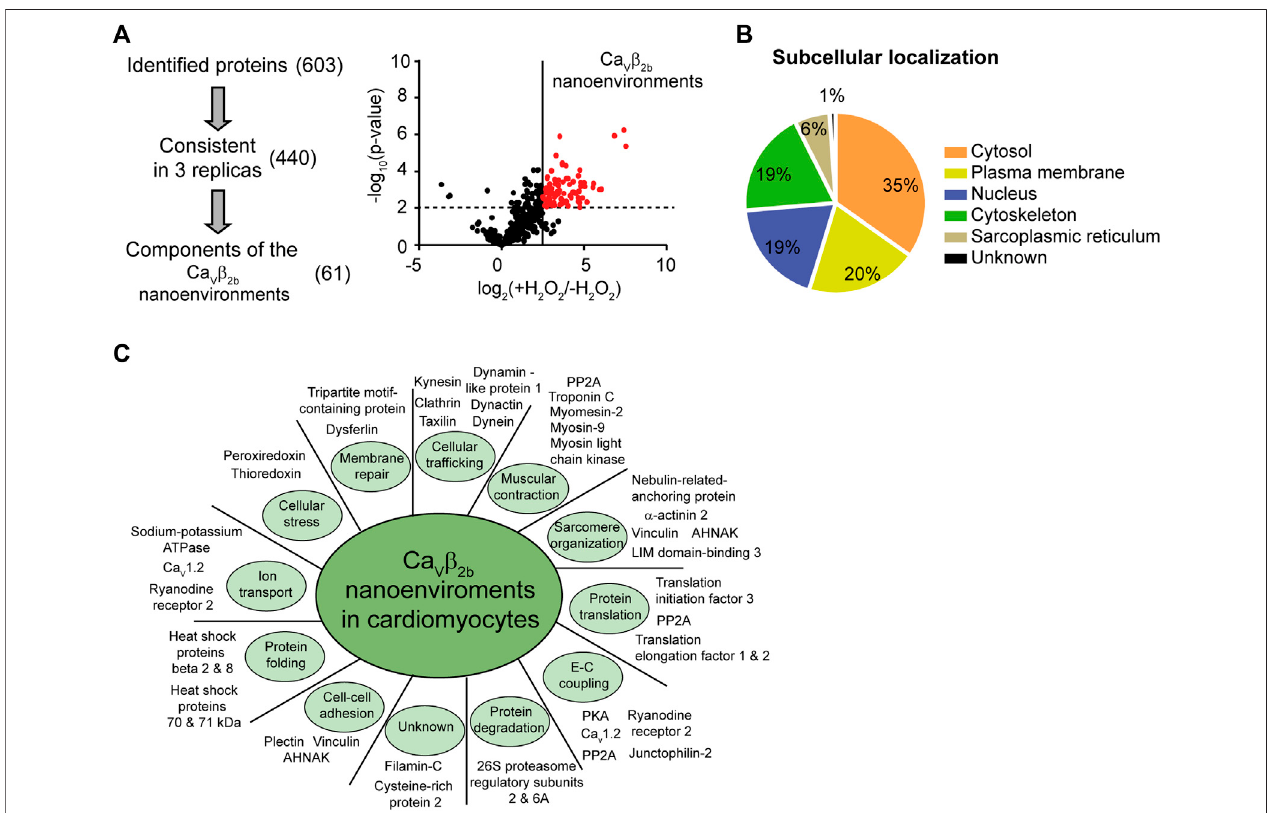
FIGURE 2 | Identi fi cation of proteins in Ca v β 2b nanoenvironments by mass spectrometry. (A) Three staged fi lters (identi fi cation, consistency and exclusion) were used to extract high-con fi dence protein constituents of the Ca v β 2b nanoenvironments. (i) The identi fi cation fi lter included the proteins identi fi ed with more than two different peptides and at a false discovery rate of 1%. The consistency fi lter included the proteins that were identi fi ed in all the replicates. Components of Ca v β 2b nanoenvironments were accepted after an exclusion fi lter including only the proteins enriched by more than one standard deviation at p < 0.01. (ii) Differences between the logarithmized means of protein intensities in Ca v β 2b -V5-APEX2 versus control samples are plotted against the − log 10 ( p -value) in a volcano plot. Experiments were performed in triplicate. Statistical signi fi cance was set at p < 0.01, corresponding to − log 10 ( p -value) (cid:2) 2 on the y-axis, and is represented by the horizontal dashed line. The line perpendicular to the x-axis represents a fold-change cutoff. (B) Subcellular localization of the identi fi ed proteins. (C) Subset of proteins identi fi